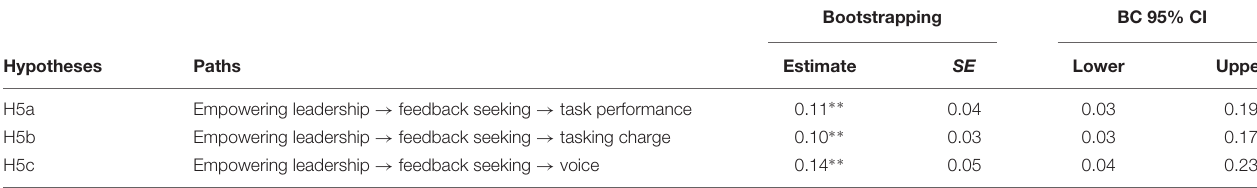
TABLE 4 | Standardized indirect path coefficients of the hypothesized model.